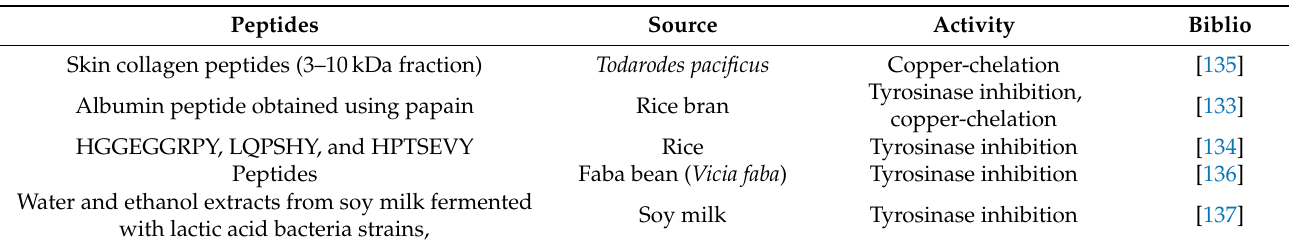
Table 2. Summary of recent studies on biopeptides that decrease tyrosinase